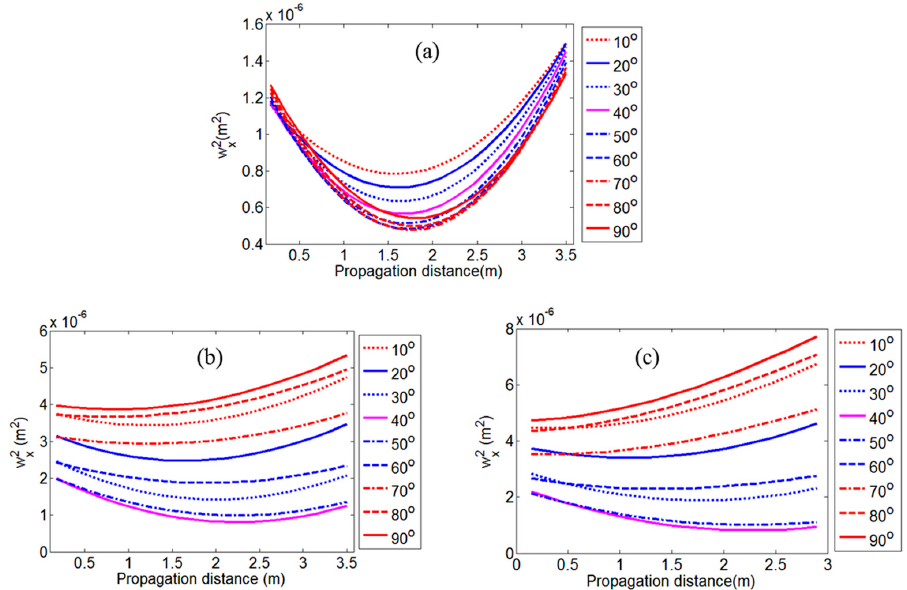
Figure 6. The beam widths w x in x -direction of Hermite-Gaussian-like modes ( a ) TELM 00 ; ( b ) TELM 20 ; and ( c ) TELM 40 versus propagation distance. The rotation angle α of the coordinate axis is 10, 20, 30, 40, 50, 60, 70, 80, 90°, respectively.